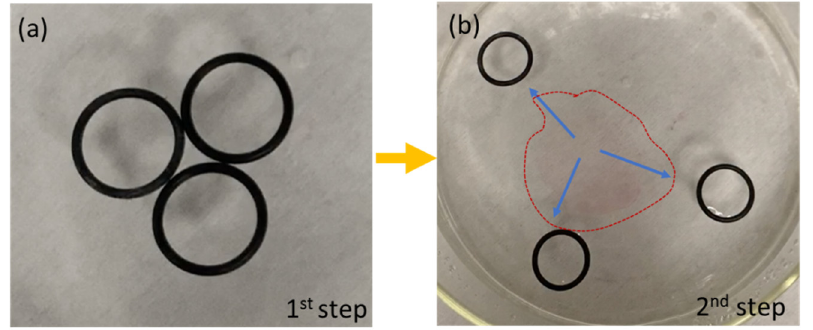
Figure 10. ( a ) Polymer droplets are dispensed in the central area, delimited by the points of contact of the three black o-rings; ( b ) the instantaneous formation of the film moves the floating objects away, inducing propulsion of multiple objects at the same time. On-the-fly formed polymer film is indicated by the dotted line.